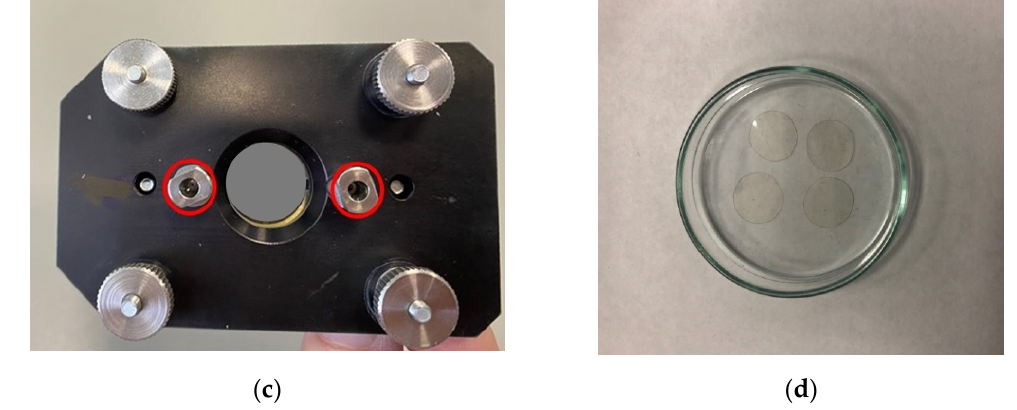
Figure 2. The cell used in FTIR spectrometry experiments. ( a ) Schematic drawing of the cell design in the case of filling with deuterium depleted water (DDW) and ordinary water. ( b ) Photo of the cell immediately after filling with ordinary water. The inlet / outlet holes are highlighted in red. ( c ) Photo of the cell immediately after filling with DDW. The inlet / outlet holes are highlighted in red. ( d ) Photo of the Nafion plates used in FTIR experiments.